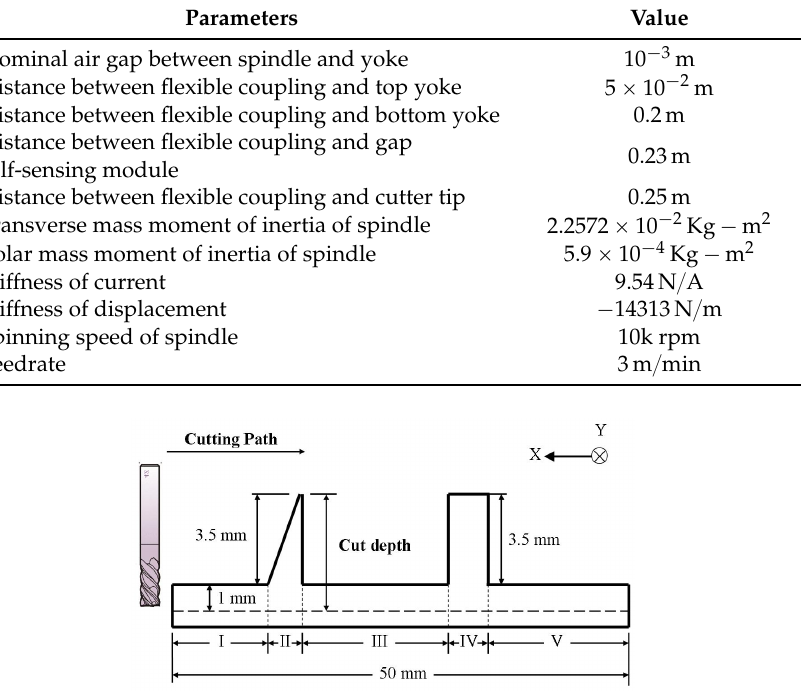
Appl. Sci. 2016 , 6 , 52 Figure 10. Profile of workpiece for numerical simulation. Figure 10. Profile of workpiece for numerical simulation.